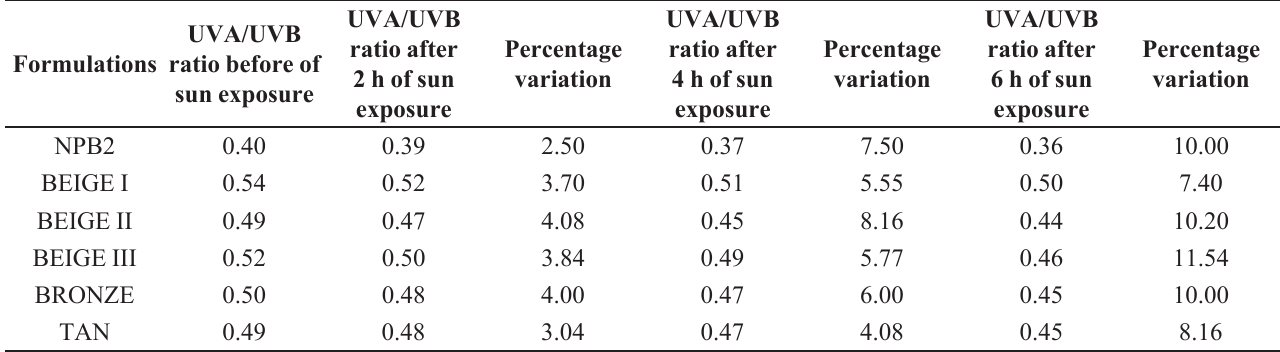
TABLE IX - UVA/UVB ratios of each photoprotective formulation, before and after 2 h, 4 h and 6 h of sun exposure, obtained by transmittance spectrophotometry and the calculation of the percentage variation of the UVA/UVB ratio after each period of sun